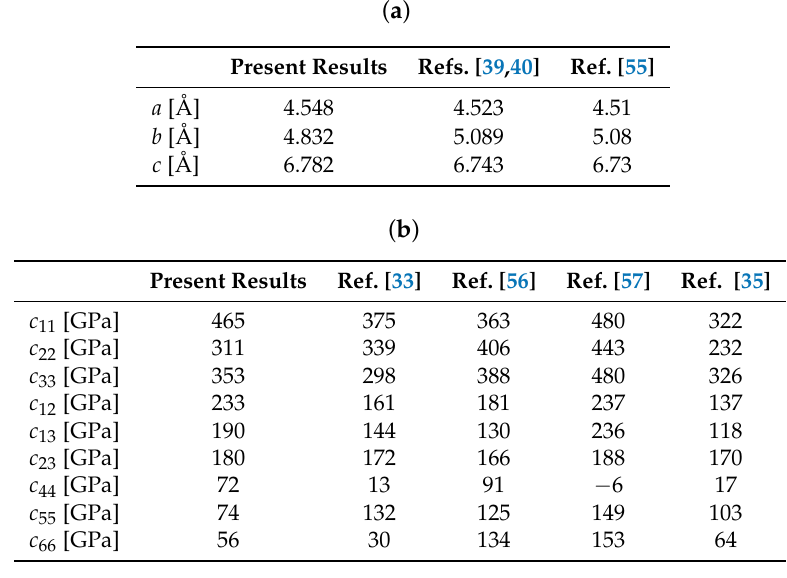
Table 1. Lattice constants ( a ) and elastic constants ( b ) of cementite: present results compared with literature